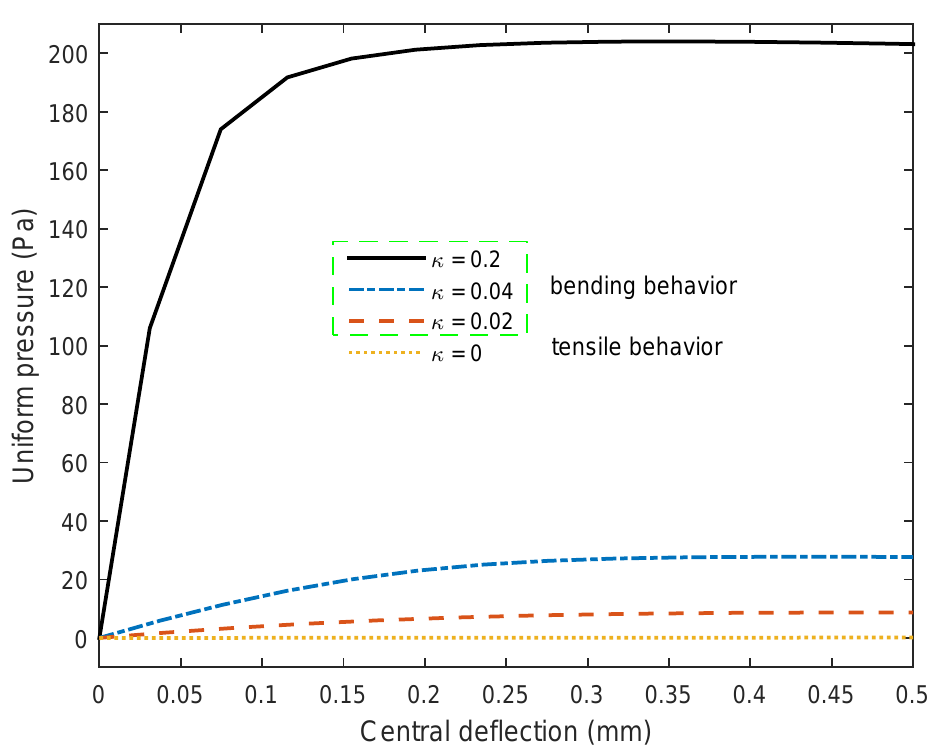
Figure 11. Effect of curvature on nonlinear response of the fully clamped FG-CNTRC cylindrical = 0.11, UD distribution. membrane with h = 0.5 mm, V ∗ CNT